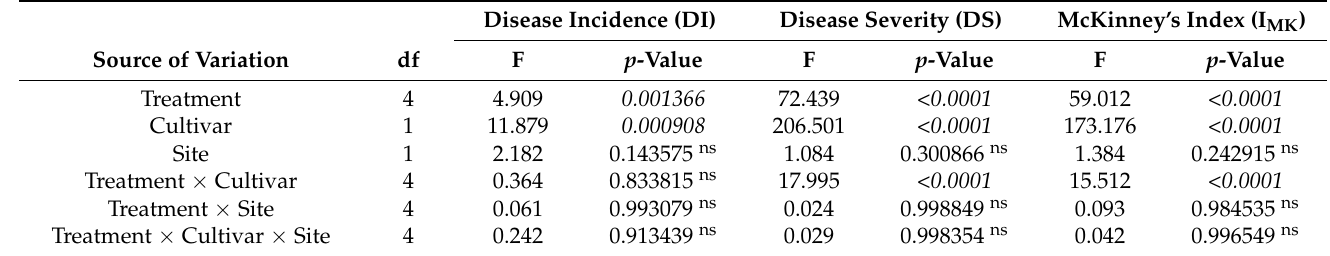
Figure 1. Climate data and main phenological stages of grapevines detected in the 2020 season, from April to September, by the weather stations of Novara di Sicilia and Patti (ME). T = temperature; RH = relative humidity. Table 1. Effects of single factors and their interactions in ANOVA on the powdery mildew infection on wine grape caused by Erysiphe necator over